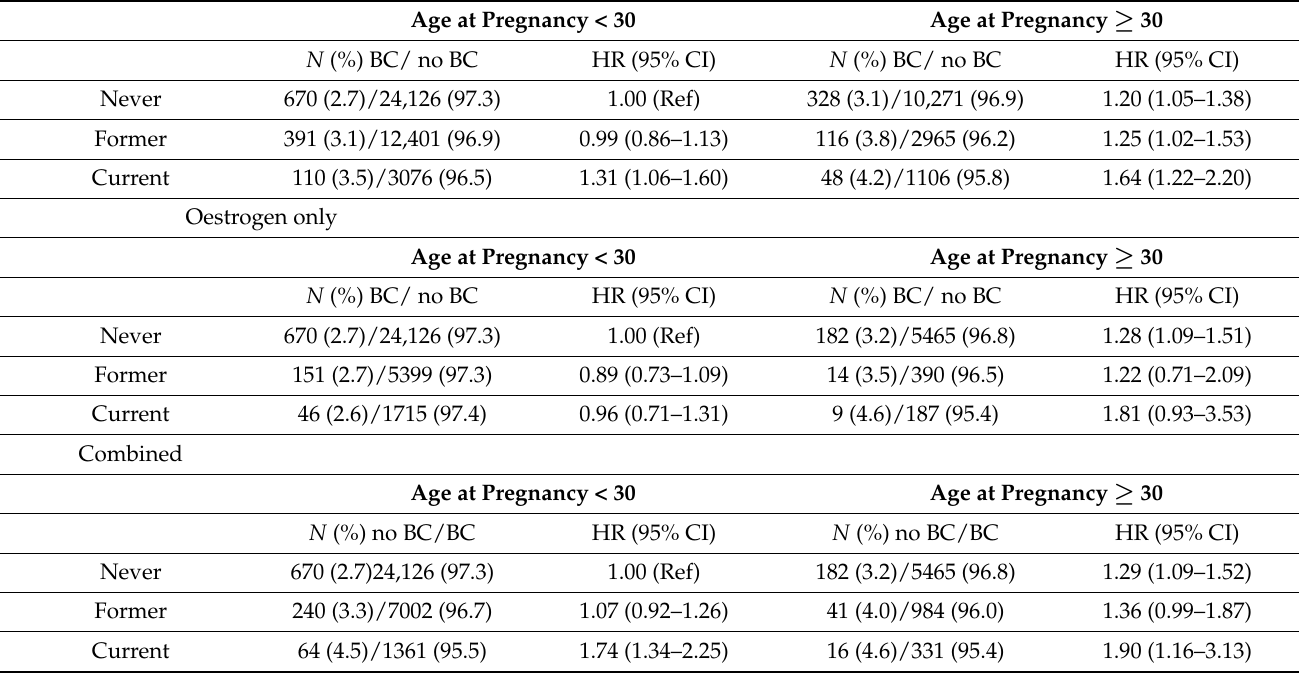
Table 2. MHT status and BC risk and age of pregnancy > 30 and nulliparity.